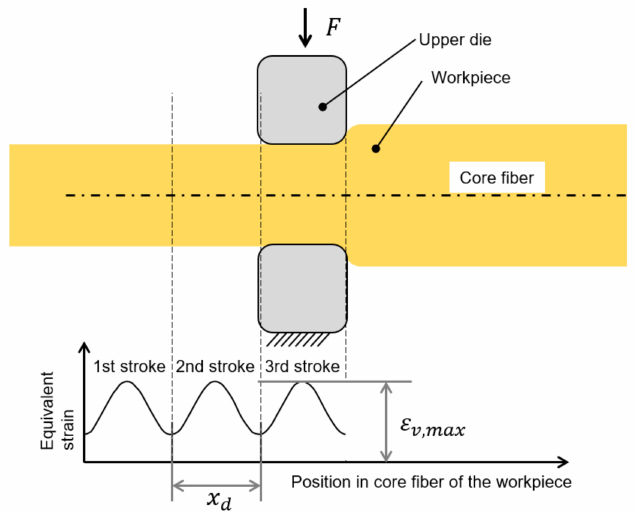
Figure 2. Calculation of the equivalent strain along the core